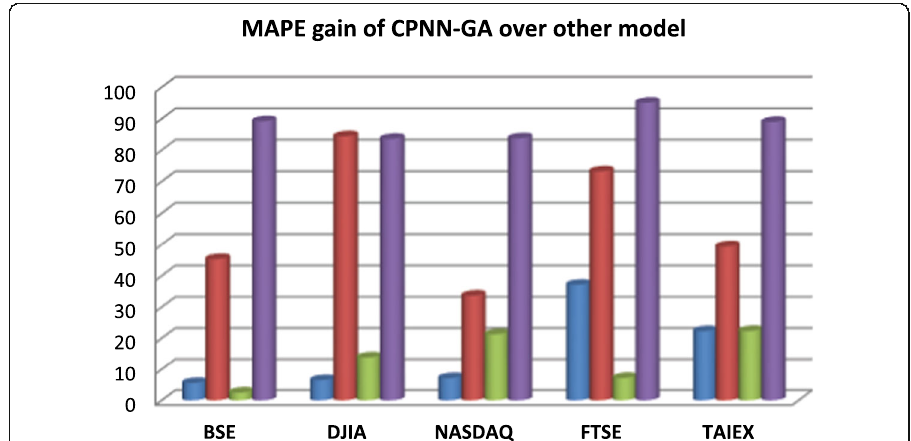
Fig. 5 MAPE gain of CPNN-GA over CPNN-GD, RBFNN, MLP-GA, and MLP-GD considering five stock indices. CPNN-GD, RBFNN, MLP-GA,